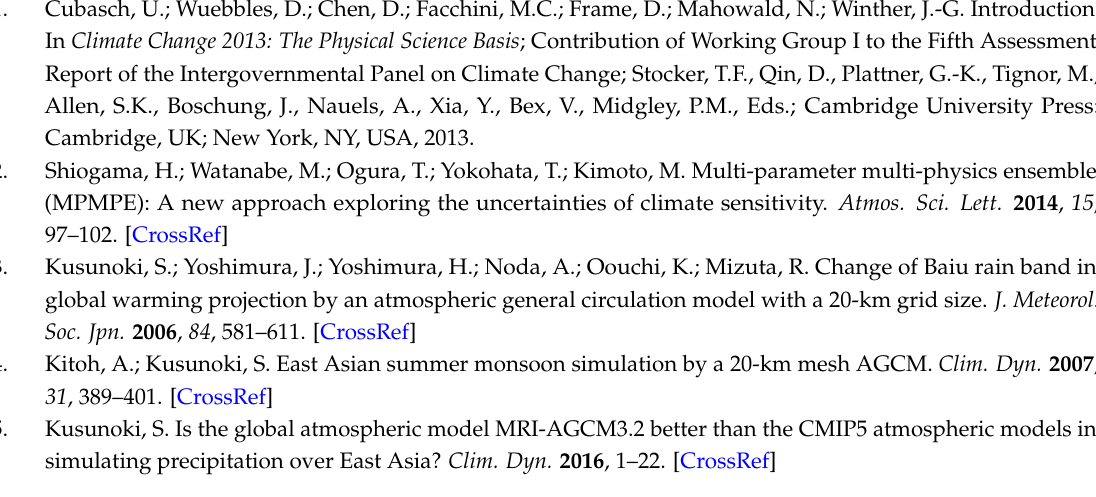
study, Figure S1: Comparison among observations for PAV, Figure S2: Comparison among simulations for PAV, Figure S3: Same as Figure S2 but for R5d, Figure S4: Root mean square errors of global distribution of precipitation indices between observations by GPCP 1ddv1.2 and model simulations, Figure S5: Same as Figure S4 but for bias, Figure S6: Dependence of model skill on the grid spacing of 31 models including 7 MRI-AGCM3.2 models and 24 CMIP5 atmospheric models, Figure S7: Correlation coefficients between the skill and grid size of 31 models, Figure S8: Same as Figure 5 but for 850 hPa height, Figure S9: Comparison between future changes in PAV by atmospheric model and AOGCM, ANalysis Of VAriance (ANOVA): Technical